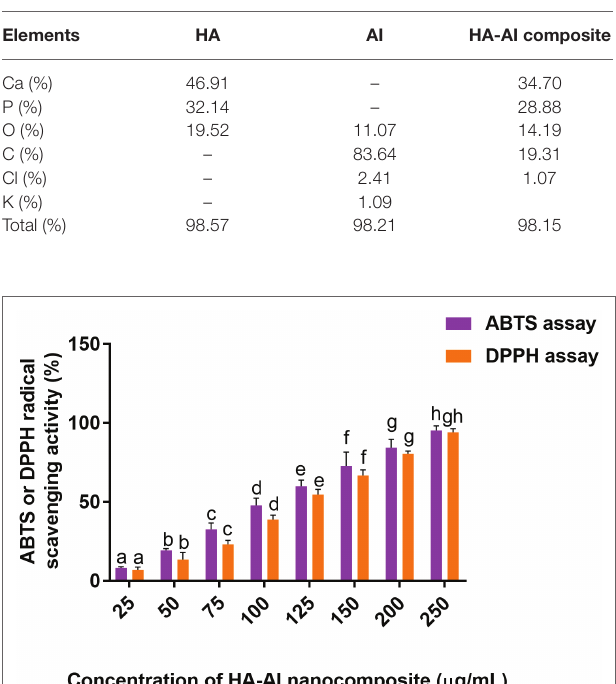
TABLE 1 | Elemental analysis of hydroxyapatite (HA), A. indica (AI), and HA-AI composite by SEM-EDX.